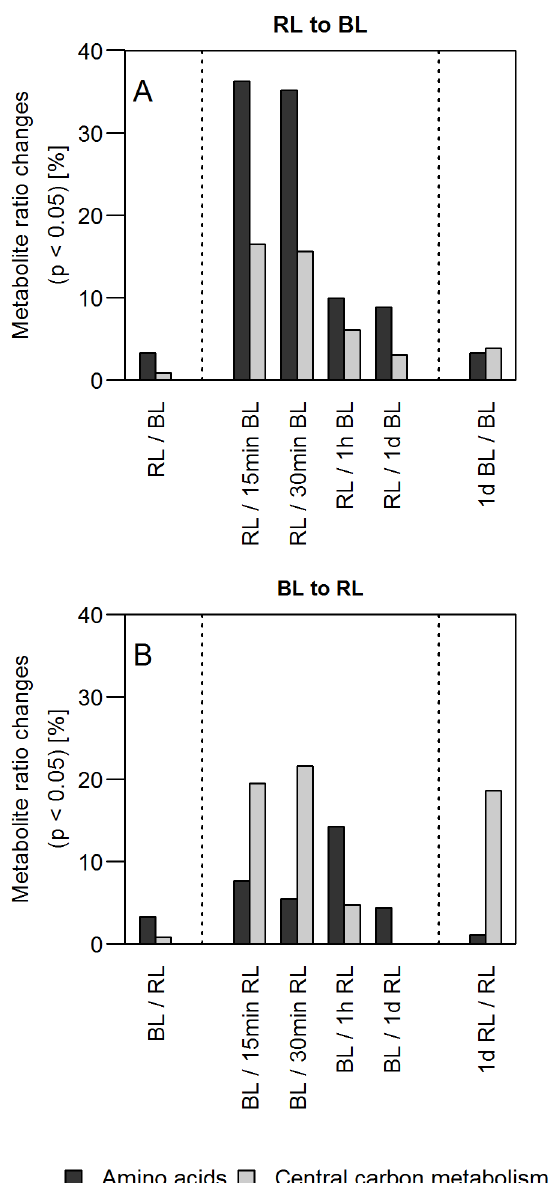
Figure 7. Changes in the metabolic ratios. All possible metabolite ratios (e.g. glucose-6P to fructose-6P) of the measured amino acids (black) or of the metabolites of the central carbon metabolism (grey) were calculated for each time point. The figure shows the rate of significant changes of these ratios between the time points given under each bar (e.g. 10% means that 10% of all metabolite ratios between these time points change significantly, p , 0.05). This acts as a value for metabolome reorganization. Given are the relevant time points for the (A) RL to BL shift and (B) the BL to RL shift. The left hand bar is similar for (A) and (B) and compares the RL and BL pre-acclimated cultures. The bars in the middle illustrate the changes between shifted cultures to the light quality they were shifted from. The right hand bar compares the shifted cultures at 1 d after the shift to the light quality they were shifted